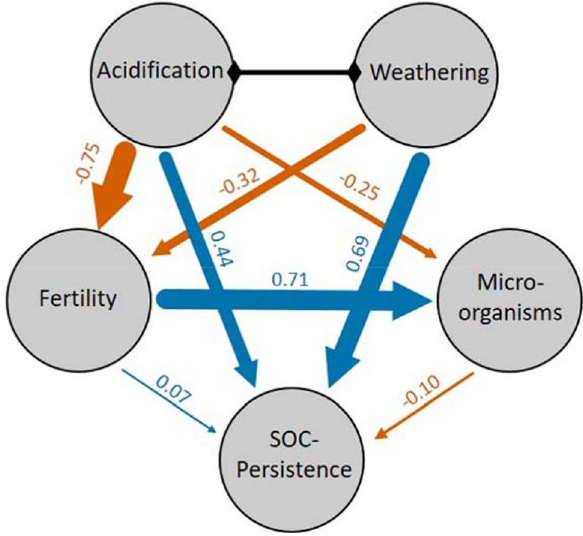
Figure 3. Median effect sizes between the latent variables of the structural equation model. Blue arrows indicate positive, orange arrows negative relationships. Acidification and weathering were assumed to correlate. Arrow thickness is proportional to effect size, which is given by the numbers. The latent variables were loaded with manifest (i.e. measured) variables (Table